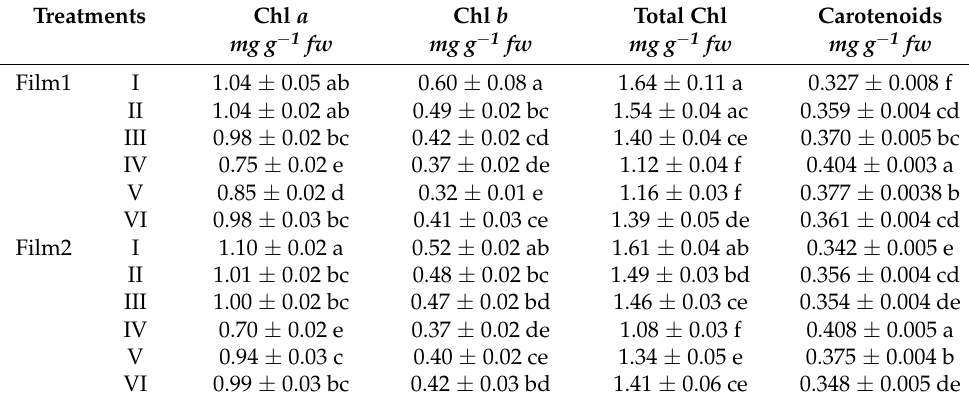
Table 9. Interactions plastic film × harvest (P × H) on the average content of chlorophyll a (Chl a ), chlorophyll b (Chl b ), total chlorophyll and carotenoids in rocket. Different letters within each column indicate significant differences at p = 0.05 (Tukey’s test).